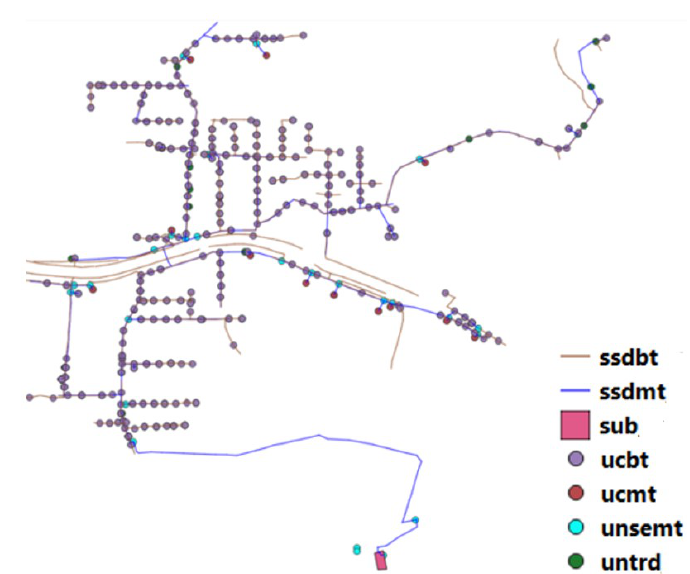
Figure 3. Real Feeder schematic